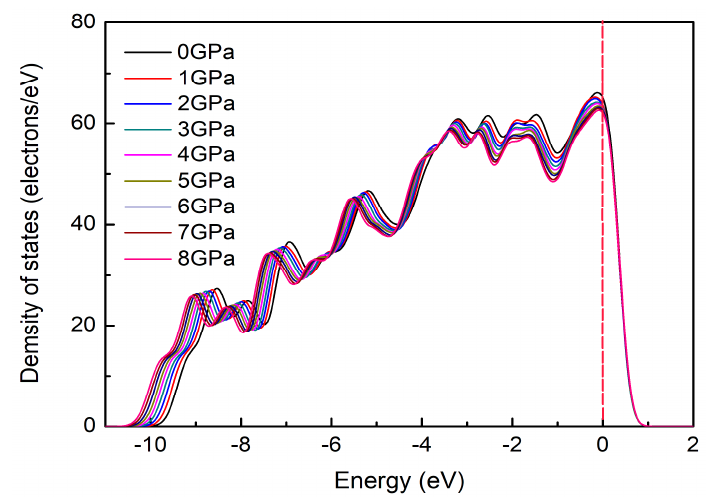
Figure 4. State density of the Mg 23 Al 30 mesophase at different pressures. Table 2. Mulliken population analysis of Mg 23 Al 30 at 0 GPa, 4 GPa and 8 GPa.